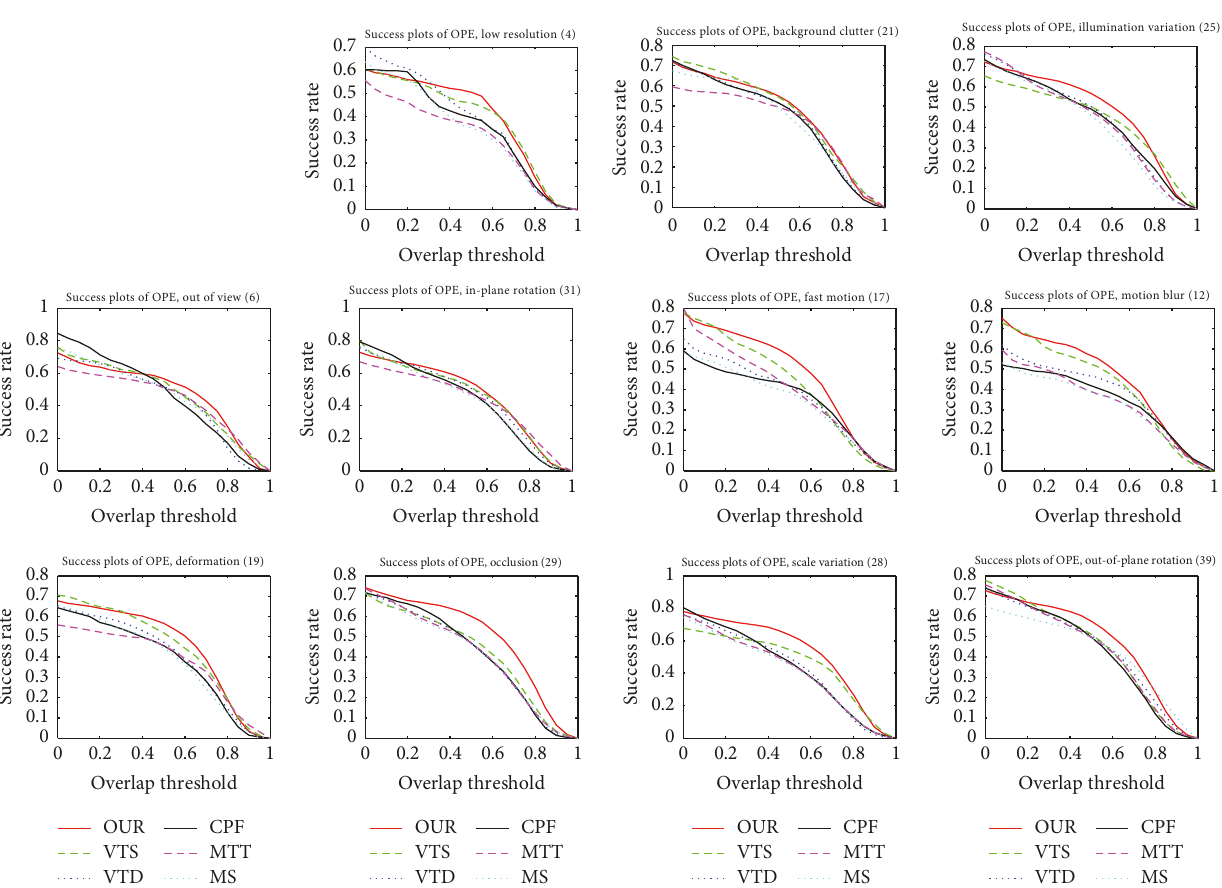
Figure 3: The success plots of videos with different